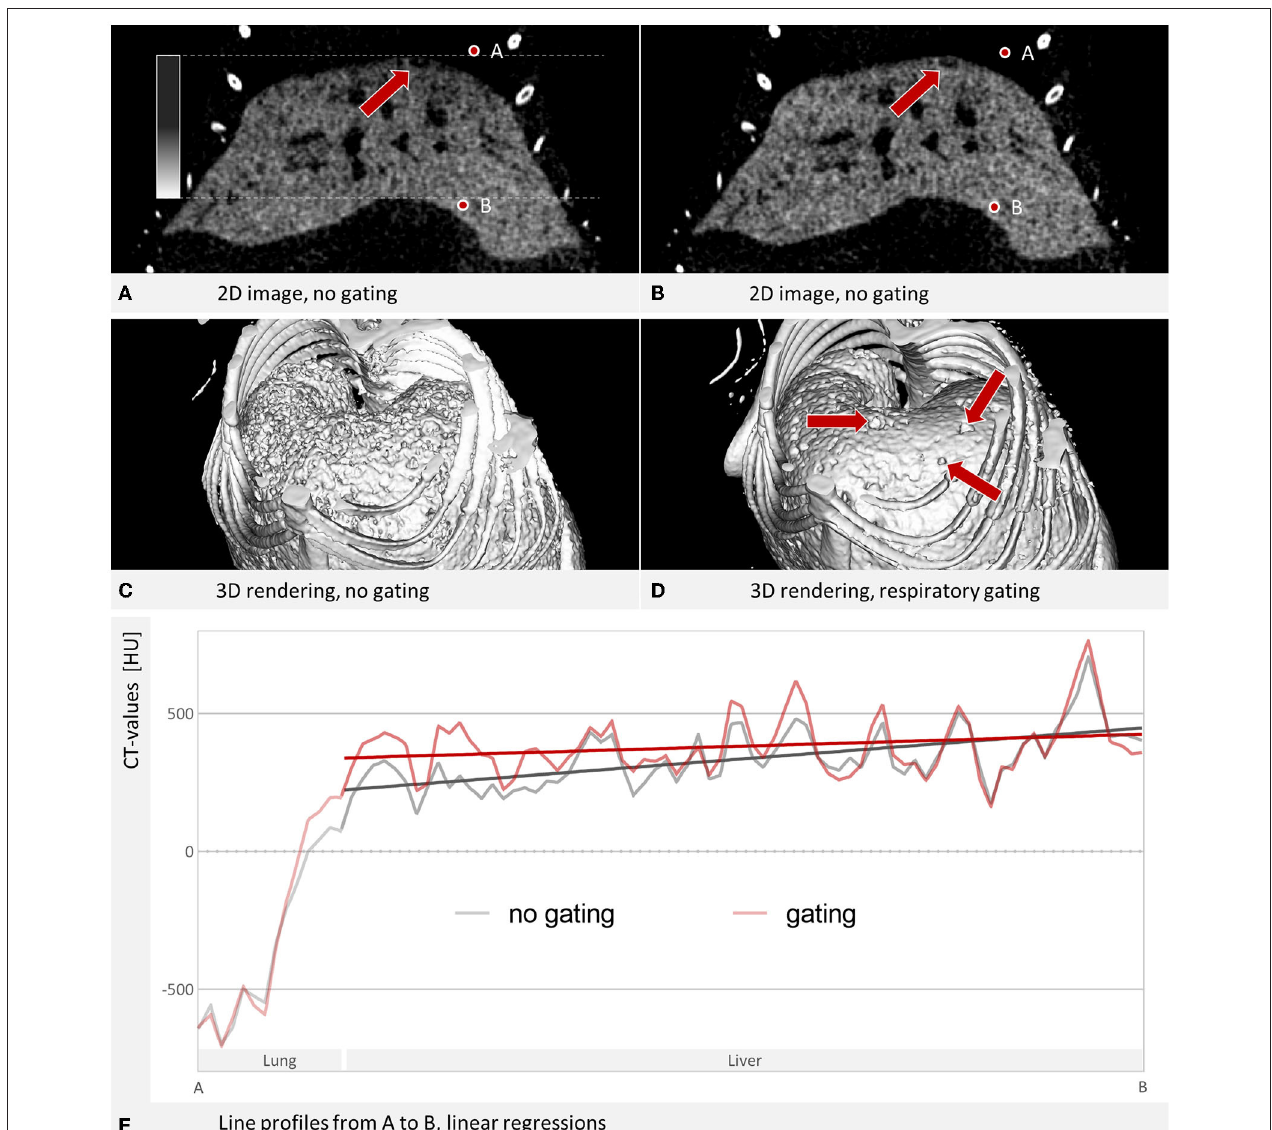
FIGURE 1 | Liver tumor imaging. (A) Coronal slice through a contrast-enhanced mouse liver, reconstructed without gating. W: 1,007 HU L: 443 HU. Tumors and blood vessels appear as dark regions. A hypodense depiction looking like a gradient at the cranial edge of the liver occurs due to contributions from the lung. The tumor marked by the arrow is hardly visible. (B) Respiratory gating improves contrast at the liver edge and increases the detectability of the marked tumor. W: 1,007 HU L: 443 HU. (C) The liver shows a rough/uneven surface in the 3D rendering. (D) The 3D rendering of a gated reconstruction shows a smoother surface with detectable tumors. (C + D) Are simple surface rendering done by the commercially available software mentioned under materials and methods. (E) Line profile from point A to point B, covering 6.96mm. Linear regressions over the segment that covers the liver show a steeper slope without gating (37.5 HU/mm) than with gating (14.6